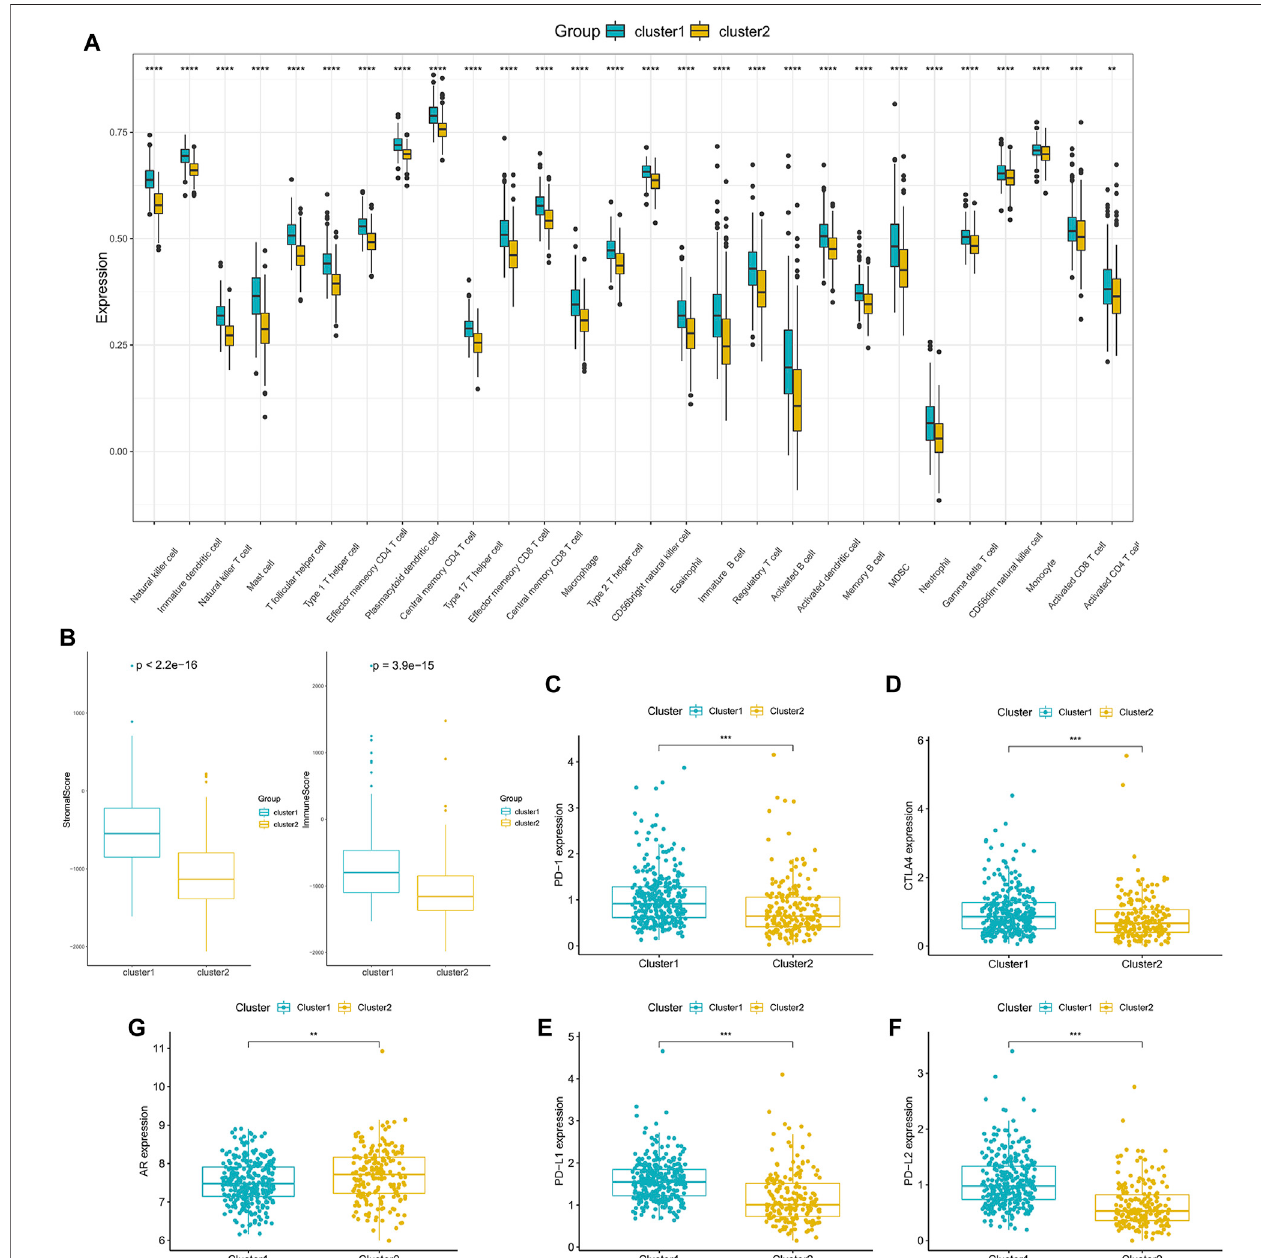
FIGURE 4 | Tumor microenvironment characteristics of different PCa subclasses: (A) The proportions of TME cells in the two clusters. (B) ImmuneScore and StromalScore of the two subgroups. (C – F) The expression of the immune checkpoint genes PD-1 (C) , CTLA4 (D) , PD-L1 (E) and PD-L2 (F) between the two clusters. (G) The expression of AR in the two clusters. (* p < 0.05, ** p < 0.01, *** p < 0.001, **** p < 0.0001).